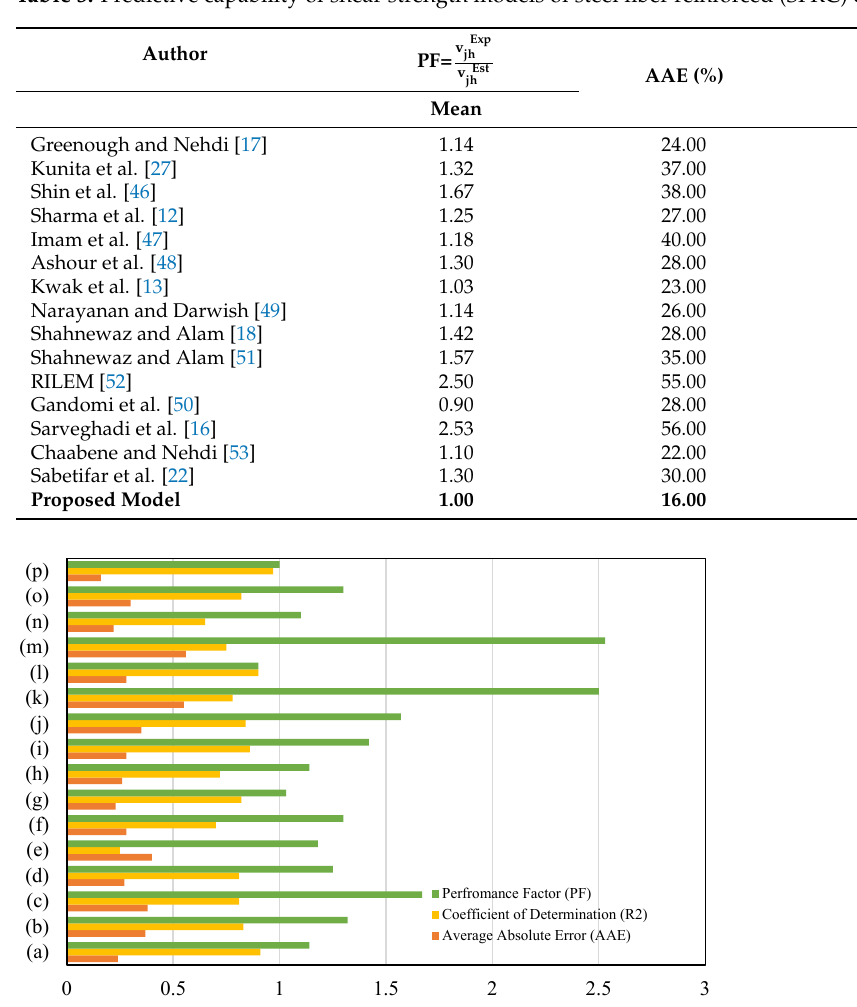
Table 3. Predictive capability of shear strength models of steel fiber reinforced (SFRC) concrete beam.